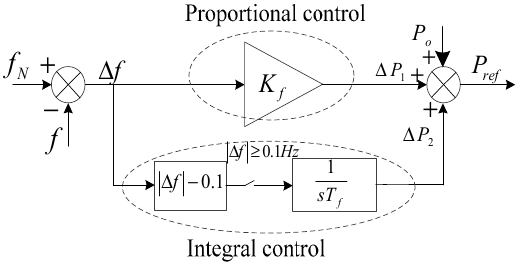
Figure 7. Integral-frequency modulation control diagram.